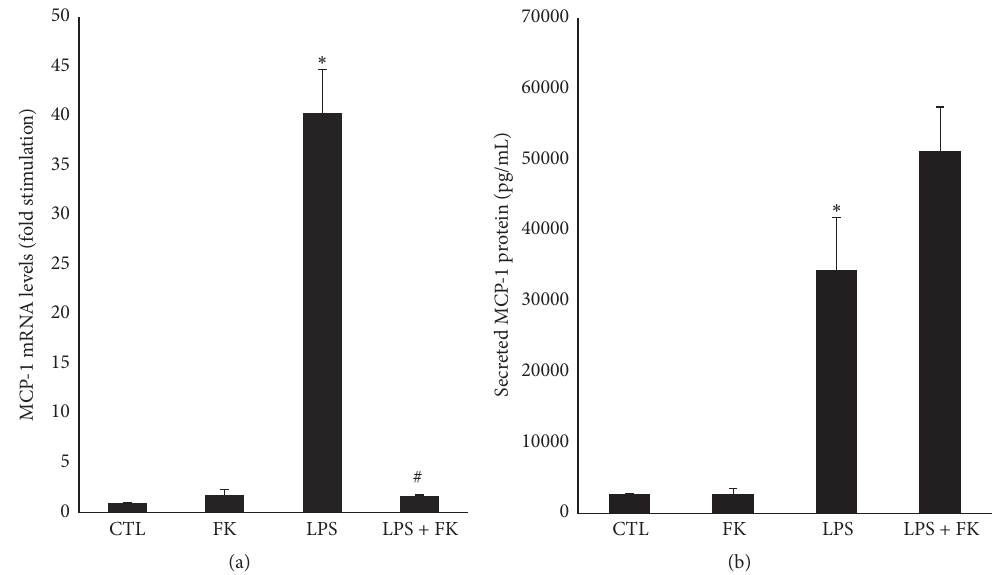
Figure 2: mRNA expression of MCP-1 (a) and MCP-1 protein secretion (b) in differentiated 3T3-L1 cells treated with LPS in the presence or absence of FK. Differentiated 3T3-L1 cells were treated as described in Materials and Methods under the following conditions: CTL, 10 𝜇 M FK, 1 𝜇 g/mL LPS, and LPS + FK. (a) The results are expressed as mRNA levels (fold stimulation over CTL set to 1) and (b) secreted MCP-1 protein levels are the means ± SEM of 3 independent experiments. Data were analyzed using 𝑡 -test for unique sample and paired 𝑡 -test; ∗ 𝑝 < 0.05 versus CTL; # 𝑝 < 0.05 versus